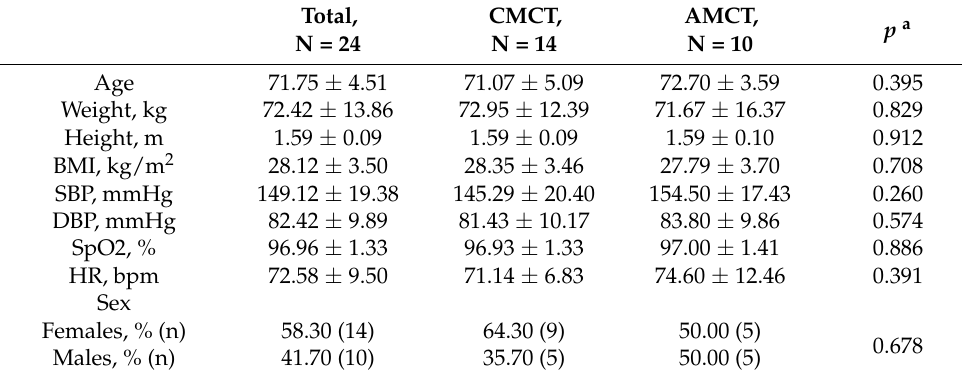
Table 1. Physical characteristics at